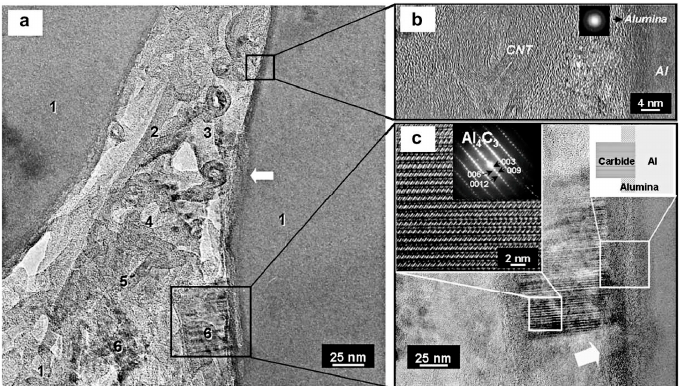
Figure 27. TEM images of the grain boundary regions in CNT-dispersed Al matrix nanocomposites: ( a ) Micrograph of the whole grain boundary including (1) Al, (2) alumina, (3) CNT, (4) amorphous carbon black, (5) graphite, and (6) Al 4 C 3 phases; ( b ) interfacial region between CNT and Al matrix; and ( c ) HRTEM image and SAD (Selected area diffraction) pattern of Al 4 C 3 phase. The region with the broken alumina phase is indicated with the white arrow [120]. (Reproduced with permission from [120], Elsevier, 2009.)